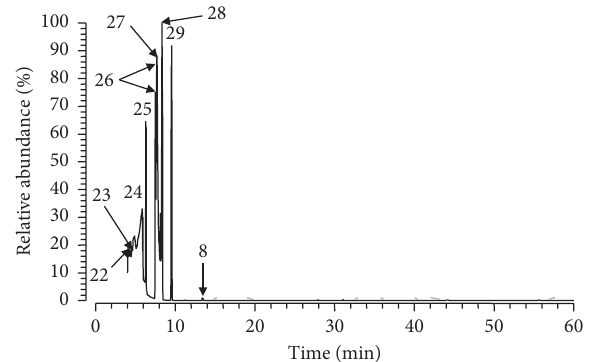
Figure 4: Total ion chromatograms of extracts of textile effluents C from the studied site. Peak numbers correspond to the chemical compounds indicated in Table